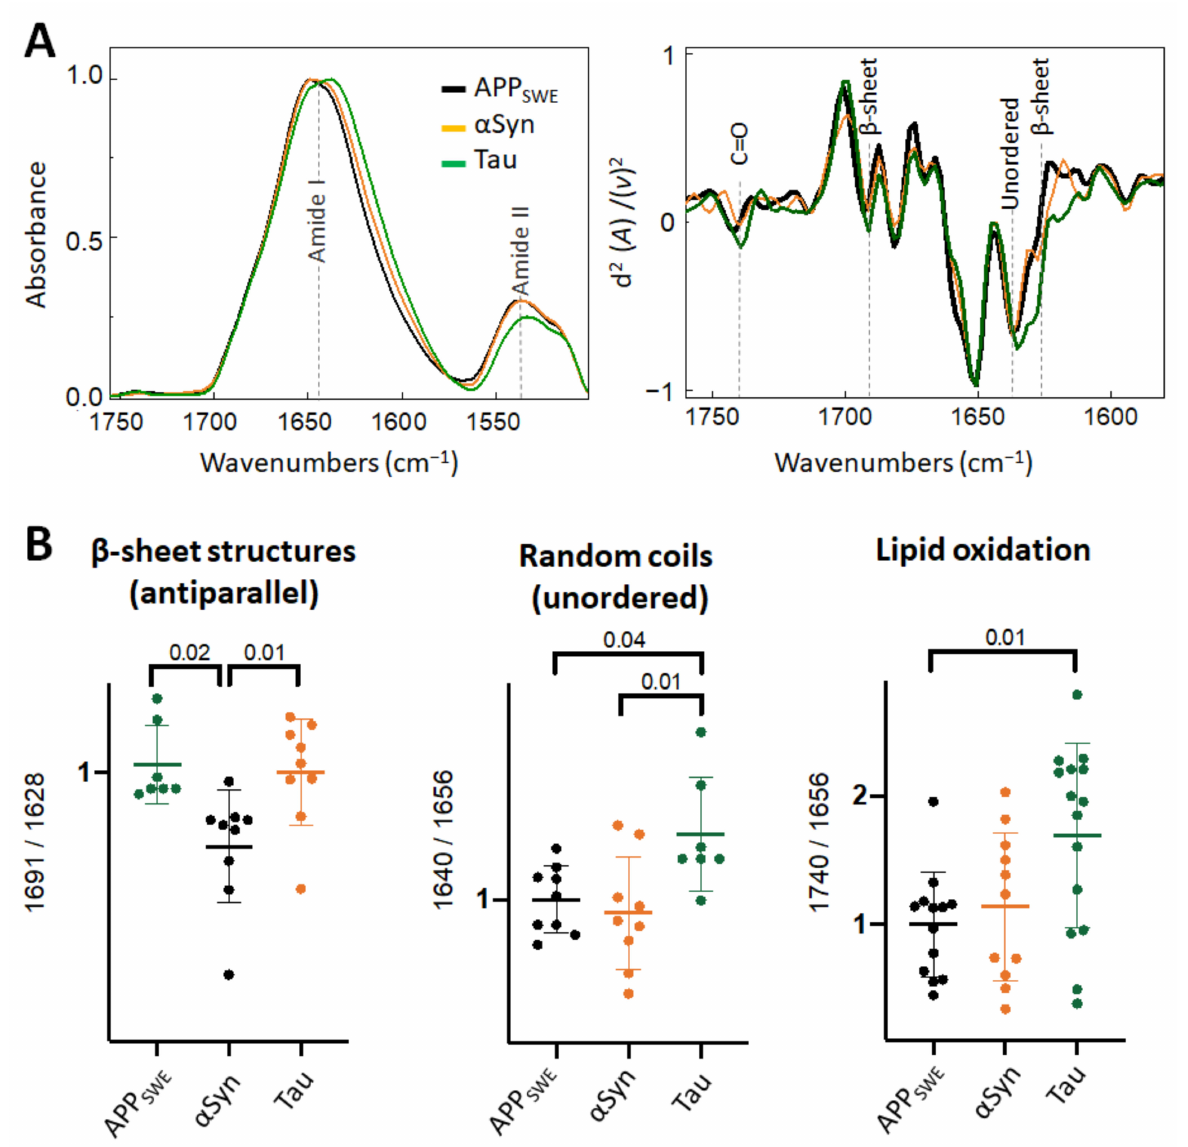
Figure 4. Comparison of structural changes in protein aggregates in the monogenic models of protein aggregation related to AD. ( A ) Averaged and normalized infrared absorbance spectra and corresponding normalized second derivatives of N2a-APP SWE , N2a- α Syn, N2a-Tau. Numbers in parenthesis indicate corresponding graphs with statistical analysis. Dashed lines indicate peak positions. ( B ) Statistical analysis of structural changes: one-way ANOVA ( p < 0.01) ± s.d. All values were normalized to the control, N2a-APP SWE cells. One dot corresponds to a single cell, n = 7–20 cells per independent measurement reproduced at least